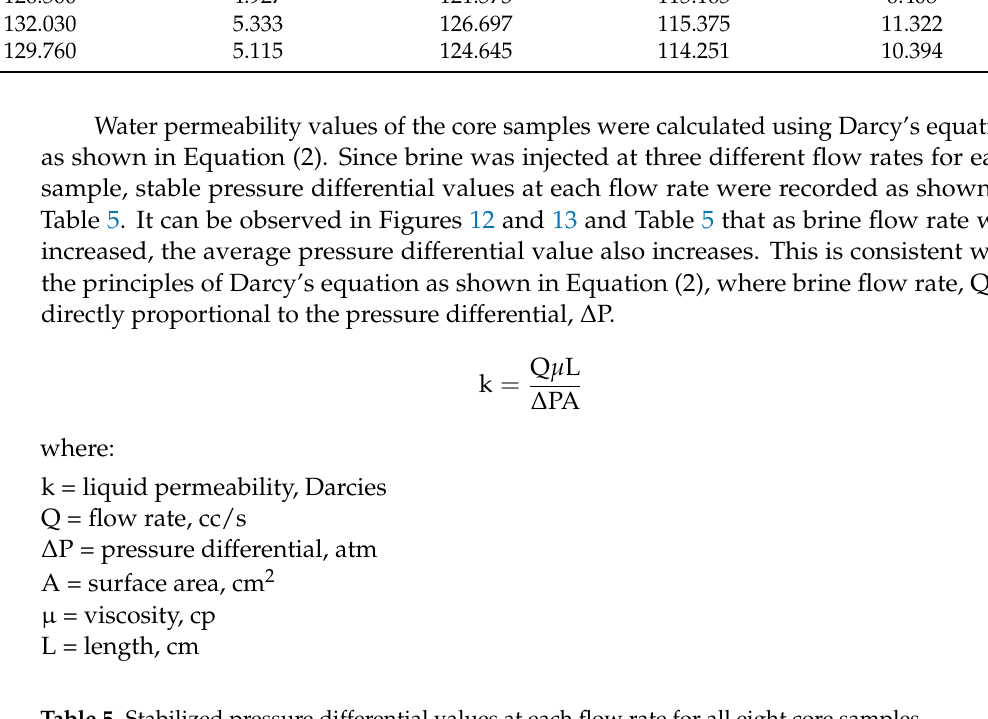
Table 5. Stabilized pressure differential values at each flow rate for all eight core